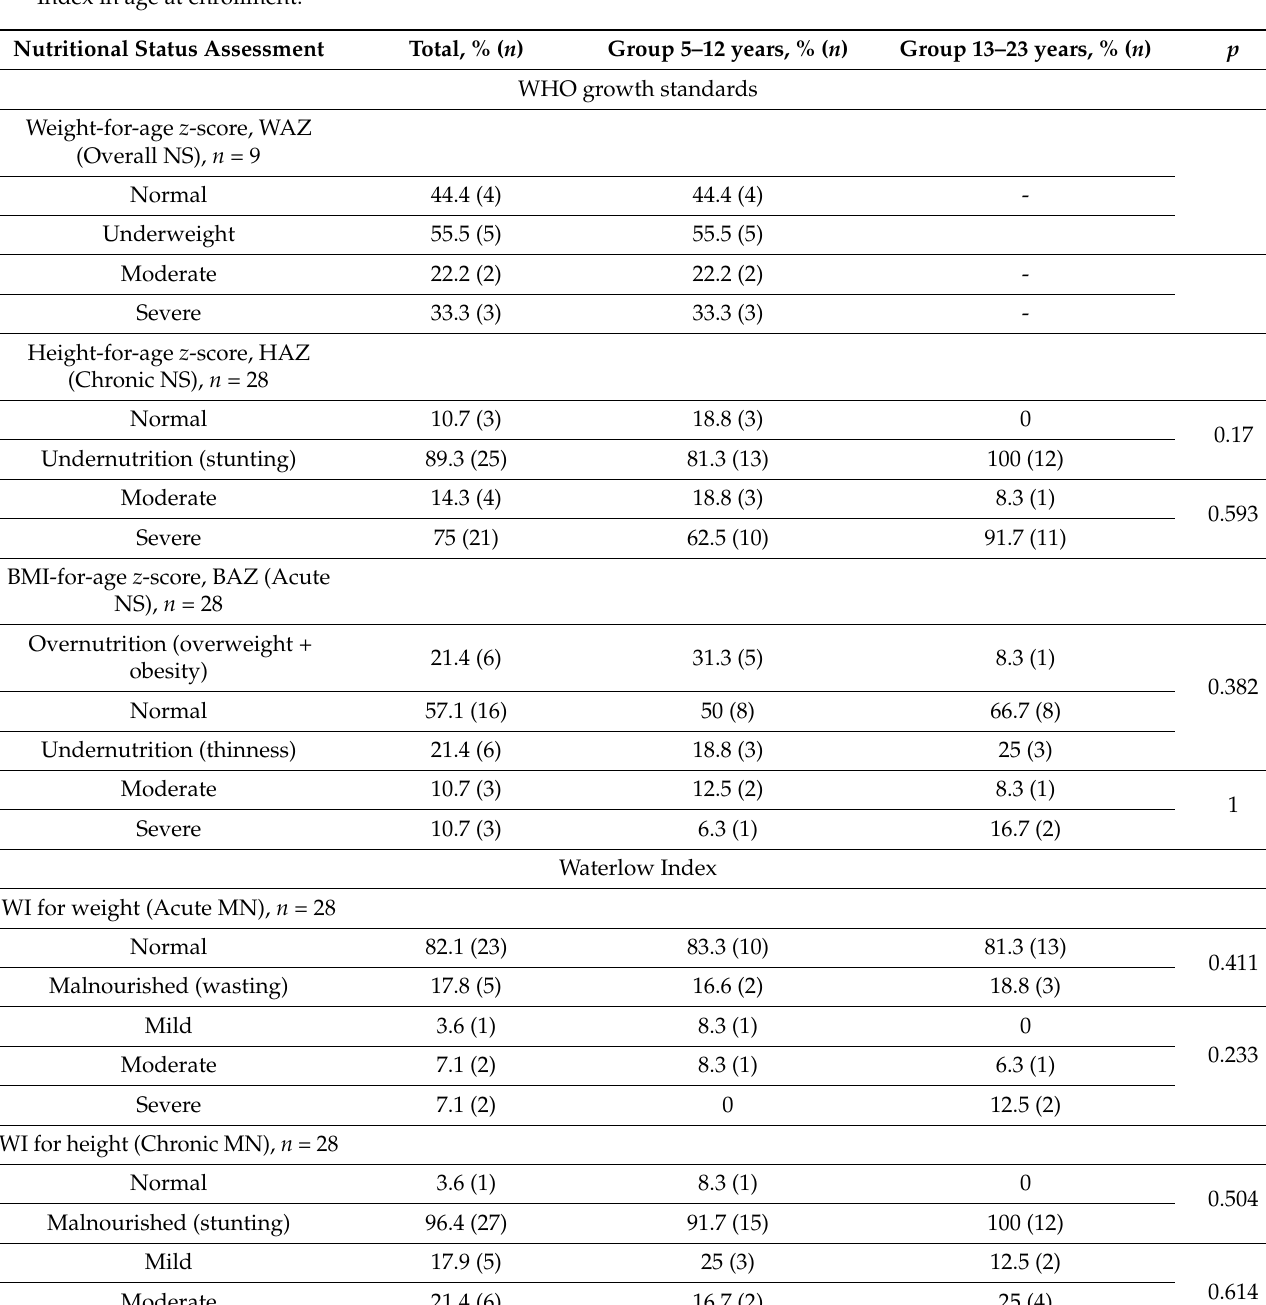
Table 5. The nutritional status according to the z -score of WHO Growth Standards (WAZ, BAZ, and HAZ) [81] and Waterlow Index in age at